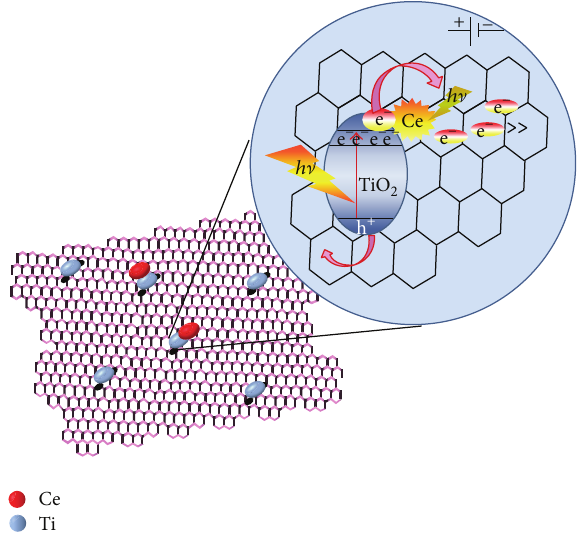
Figure 11: A schematic diagram of Ce doped RGO-TiO 2 composite and a rough presentation of photoelectron release